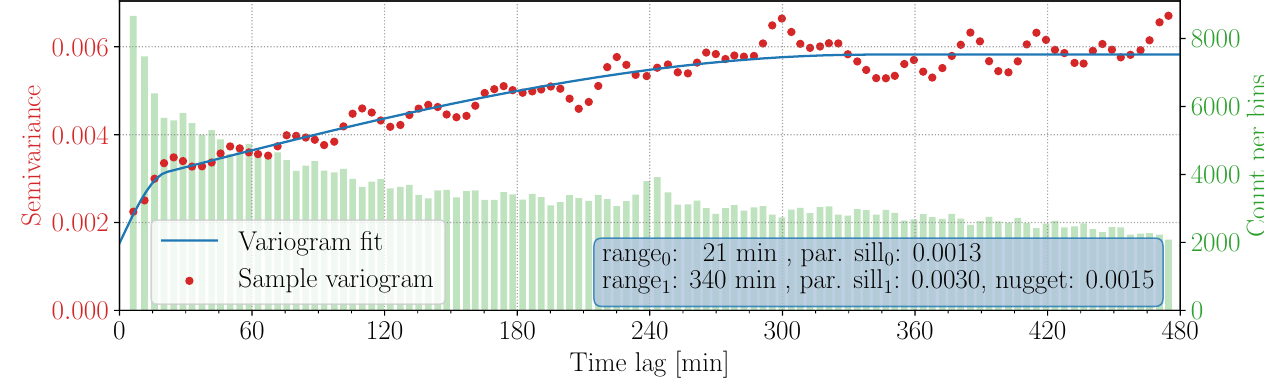
Figure 4. Sample semi-variogram (in red) and model fit (in blue) of the median of the valid Z DR values of each selected scan for the PAYERNE campaign. The number of pairs used in the computation of the semi-variogram is displayed as vertical green bars. The model parameters are presented in the blue box on the right side of the